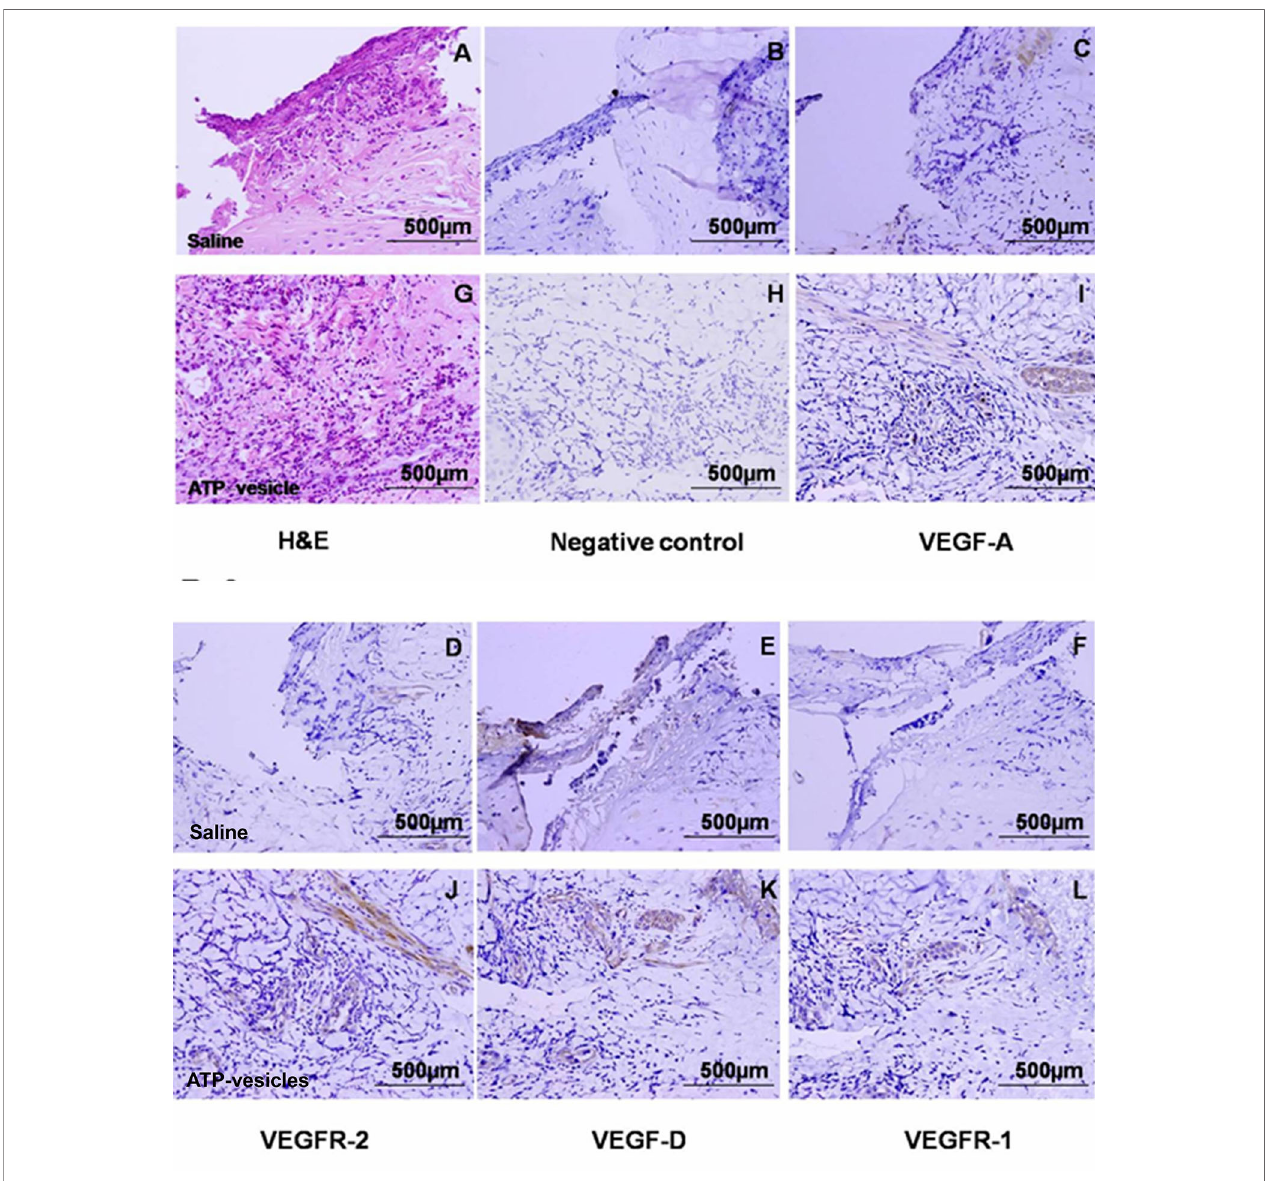
FIGURE 6 | Immunohistochemical staining of VEGFs and their receptors in wound tissues at day 6 after surgery. The expression of VEGF-A, VEGFR-2, and VEGF-D were signi fi cantly higher in the ATP-vesicle – treated groups (I , J , and K) than in the normal-saline – treated groups (C , D , and E) after 6 days of treatment. VEGFR-1 also showed some increase in ATP-vesicle-treated wounds (L) as compared with that in saline-treated wound (F) . (A and G) are hematoxylin & eosin stainings; (B and H) are negative controls. The brown color indicates DAB-positive immunostaining (scale bar = 500 m